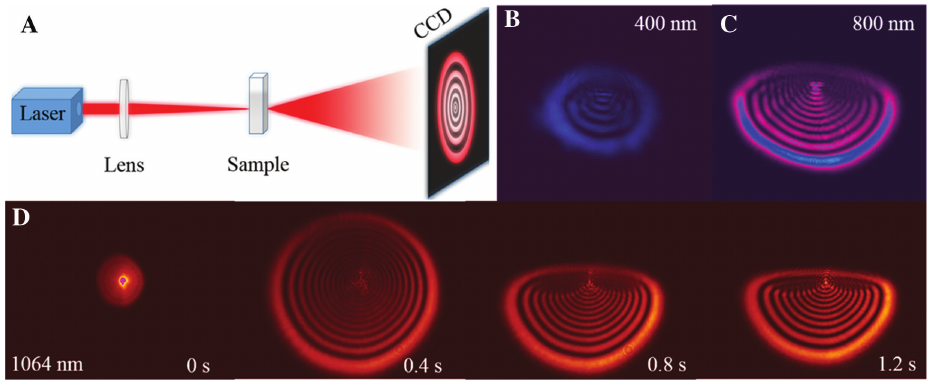
Figure 2: Broadband SSPM experiments. (A) The experimental setup diagram of the SSPM nonlinear optical experiment. (B) Stable diffraction rings at 400 nm and (C) 800 nm wavelengths. (D) Snapshots of the pattern formation under 1064 nm